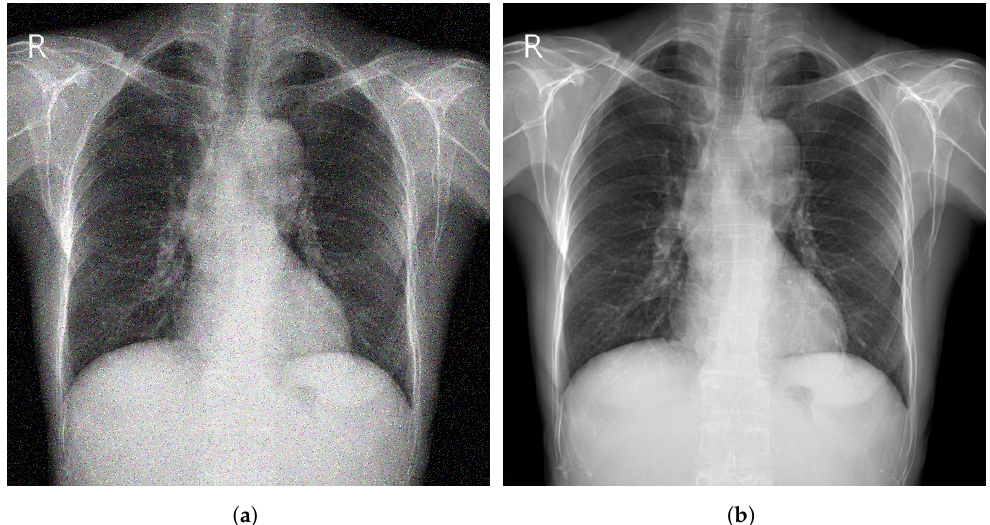
Figure 5. ( a ) Noisy CXR image from a low quality version of CheXpert dataset [44]; ( b ) Enhanced CXR